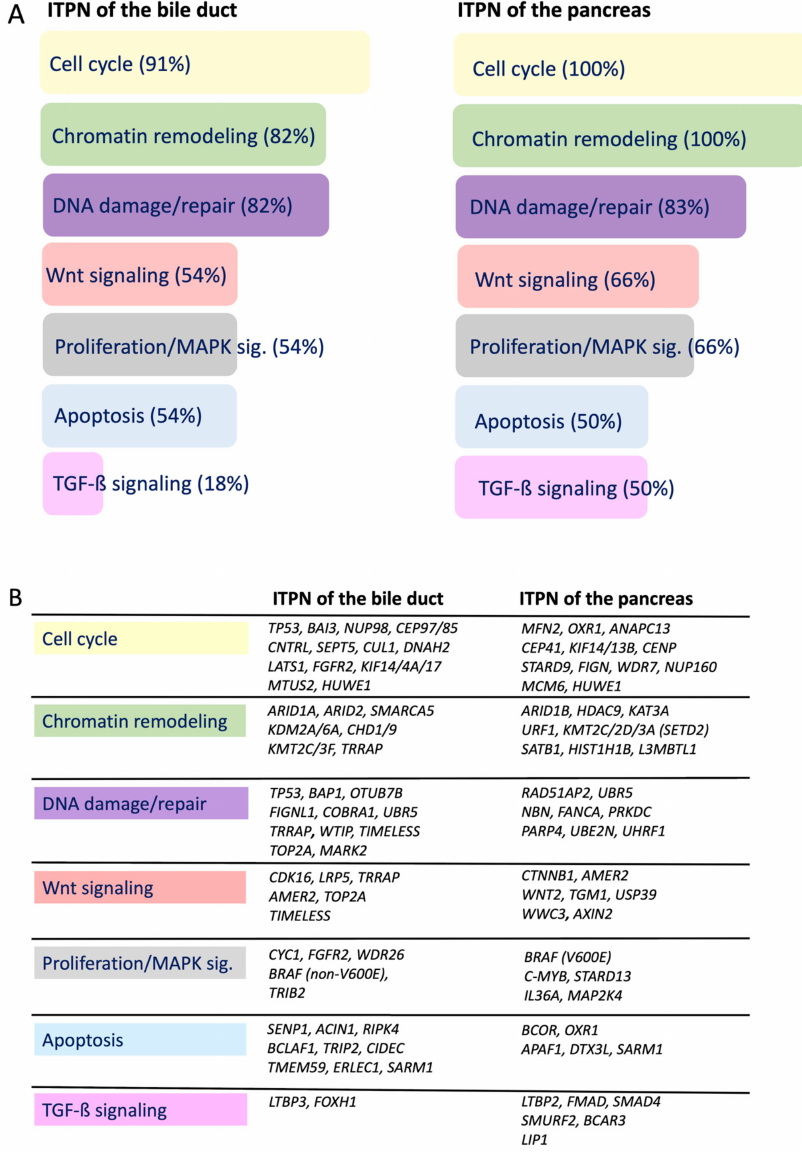
Figure 5. Identified key signaling pathways in ITPN carcinogenesis by SNV analysis (synonymous variants (SVs) excluded). Summary of commonly affected pathways by SNVs (% of all cases